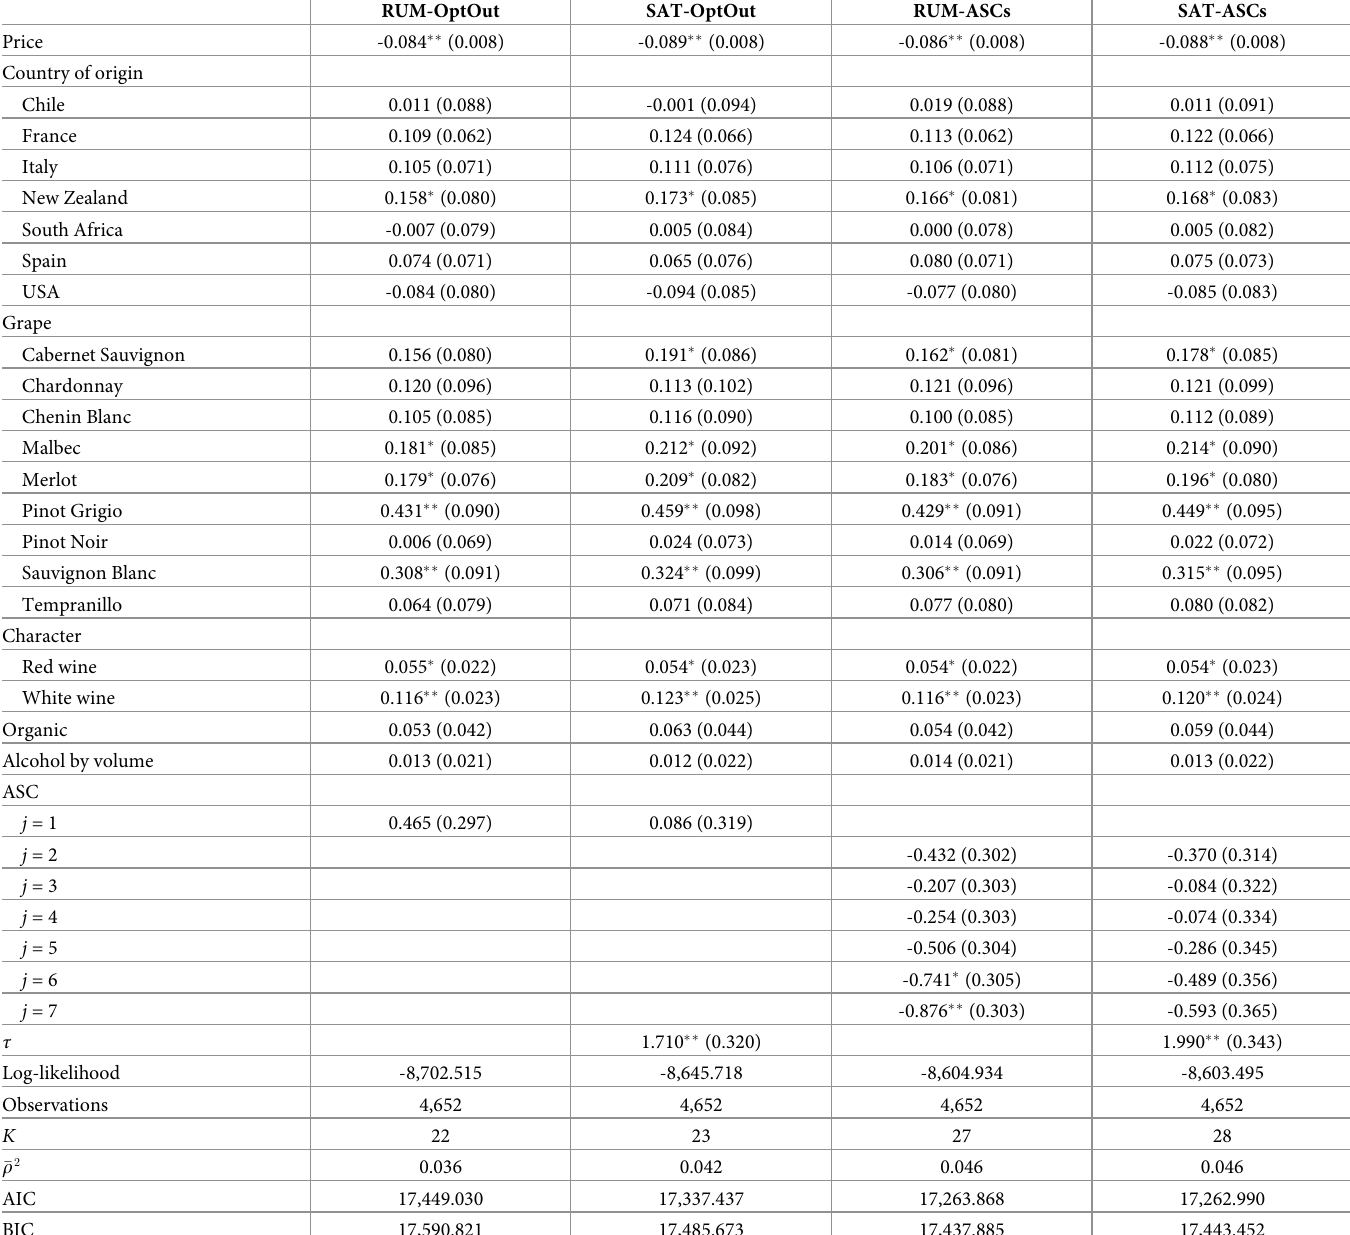
Table 5. Estimation results for treatment